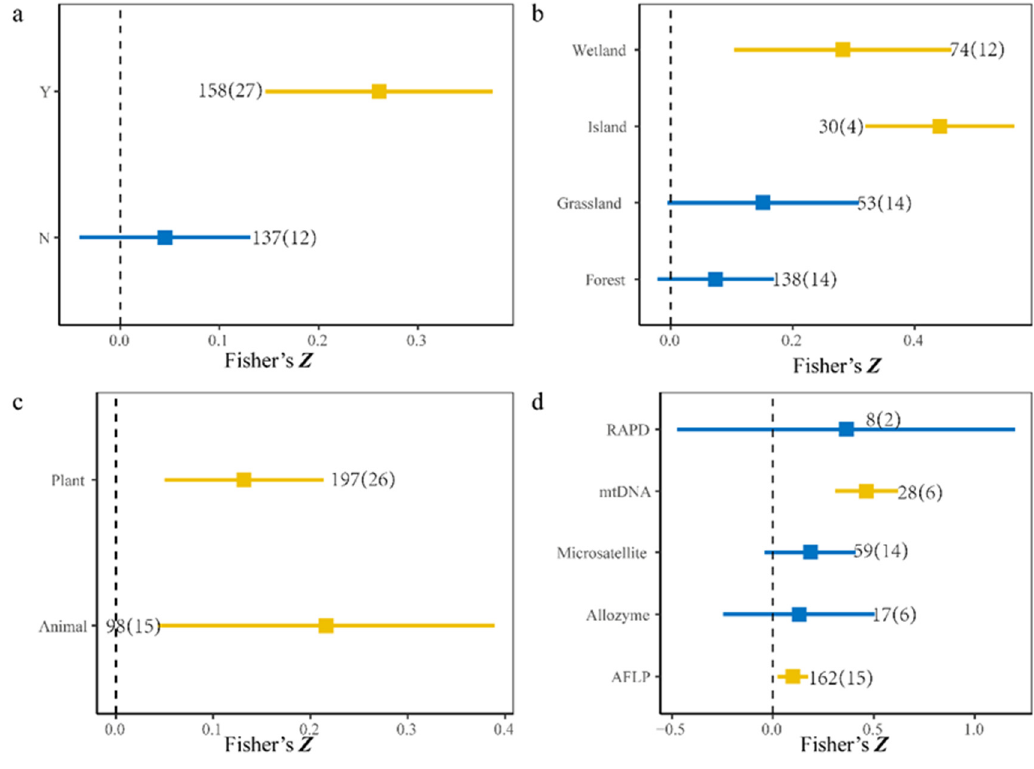
Figure 3. Cumulative effect sizes among different groups. The numbers of observations and studies are shown outside and inside the parentheses, respectively. ( a ) Y denotes discrete sampling and N denotes continuous sampling. ( b ) Cumulative effect sizes among different ecosystem types. ( c ) Cumulative effect sizes using different species. ( d ) Cumulative effect sizes using different molecular markers. Blue and yellow quadrates represent variables with 95% confidence intervals that do not overlap zero ( p < 0.05), and overlap zero ( p > 0.05), respectively.